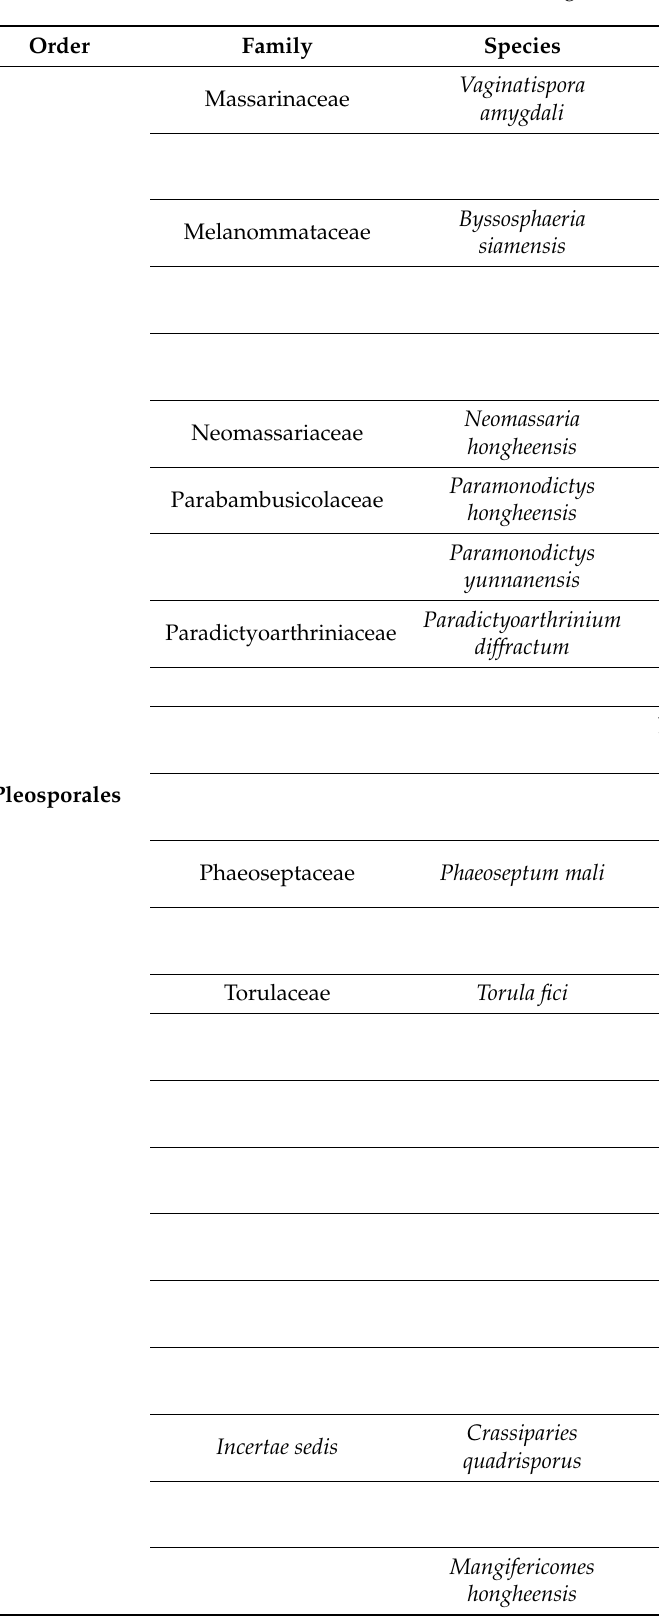
Table 1. Information of fungi isolated on mango in this study and previous